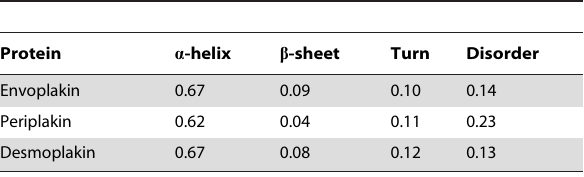
Table 1. Secondary structure content of the envoplakin and periplakin plakin